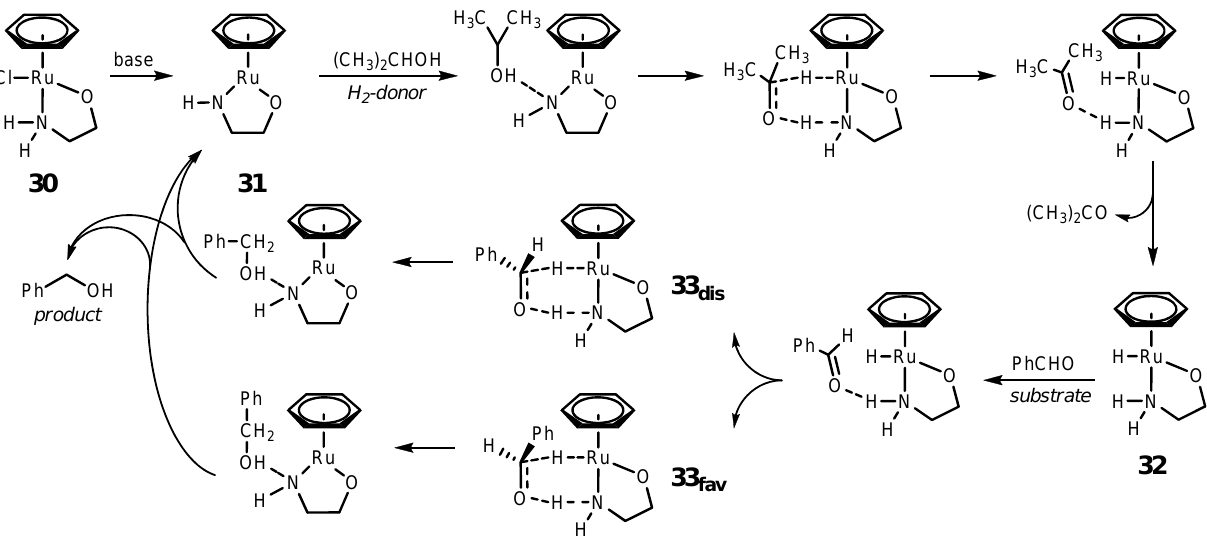
Scheme 2. Metal-ligand bifunctional mechanism: ATH of benzaldehyde using 30 and i -PrOH